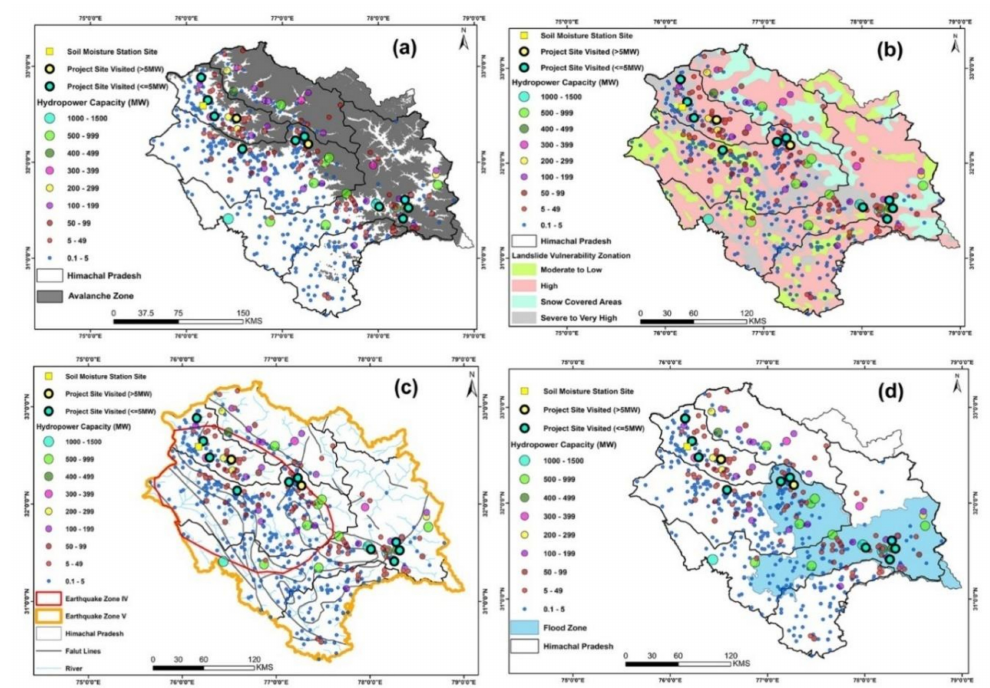
Figure 10. Spatial hazard zonation map for Himachal Pradesh covering all the basins, consisting of ( a ) avalanche, ( b ) landslide, ( c ) earthquake, ( d ) flood vulnerability, as per the National Disaster Management Authority, Ministry of Home A ff airs, Government of India.